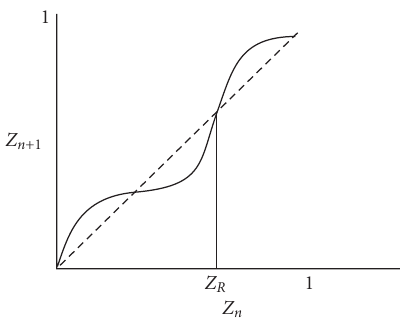
Figure 2.2. The simplest graph of f if the fixed point at Z = 1 is stable. The model: mimic ratio will tend to one of two values depending on the initial